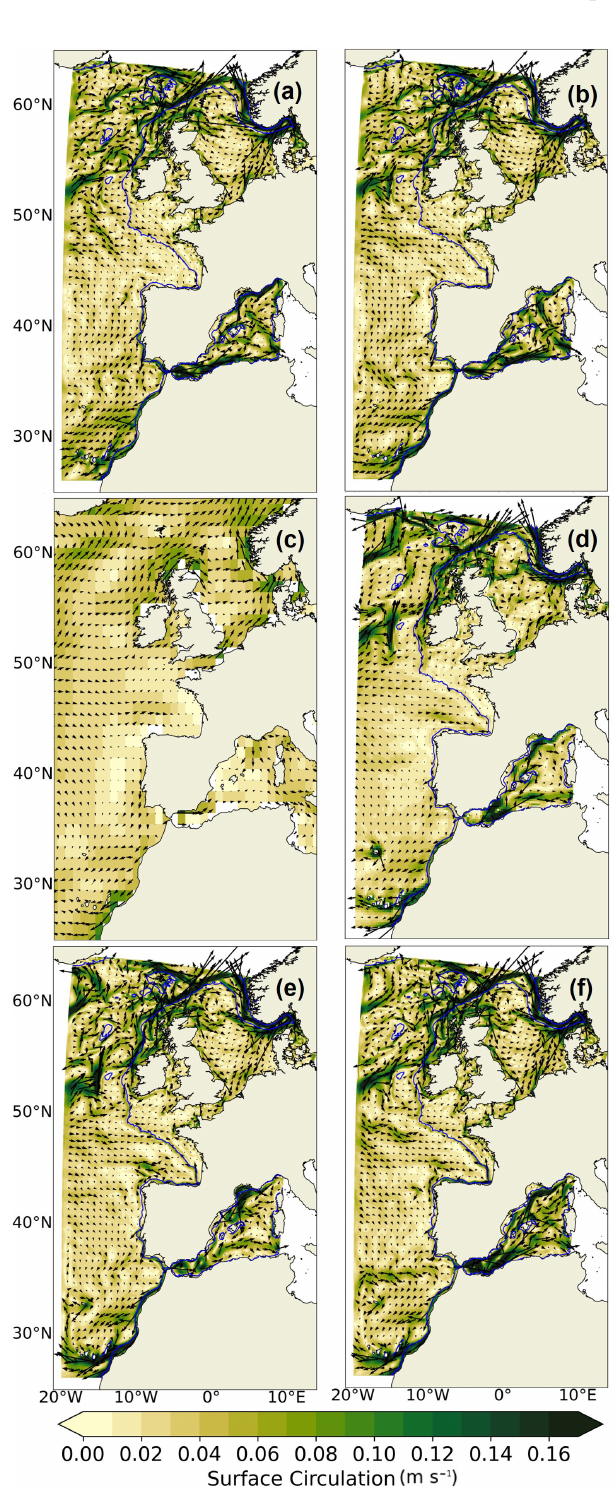
Figure 4. Surface circulation (in ms − 1 ) over the 1993–2014 pe- riod in (a) IBIRYS, (b) IBI-ERAi, (c) CNRM-CM6-1, (d) CNRM- CM6-1-HR, (e) IBI-CCS_raw and (f) IBI-CCS_corr simulations. The shelf break (defined by the 200m isobath) is indicated in